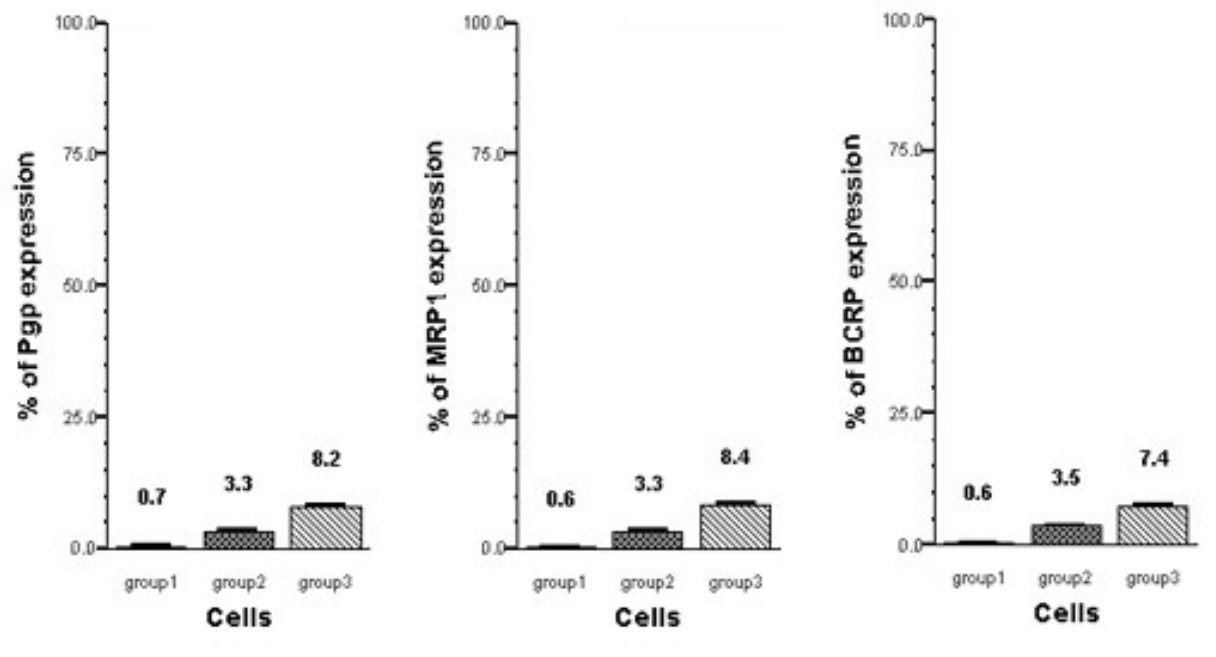
Figure 3 . Protein array determined every MDR protein expression level which was analyzed in three groups. The data represent the mean of 5